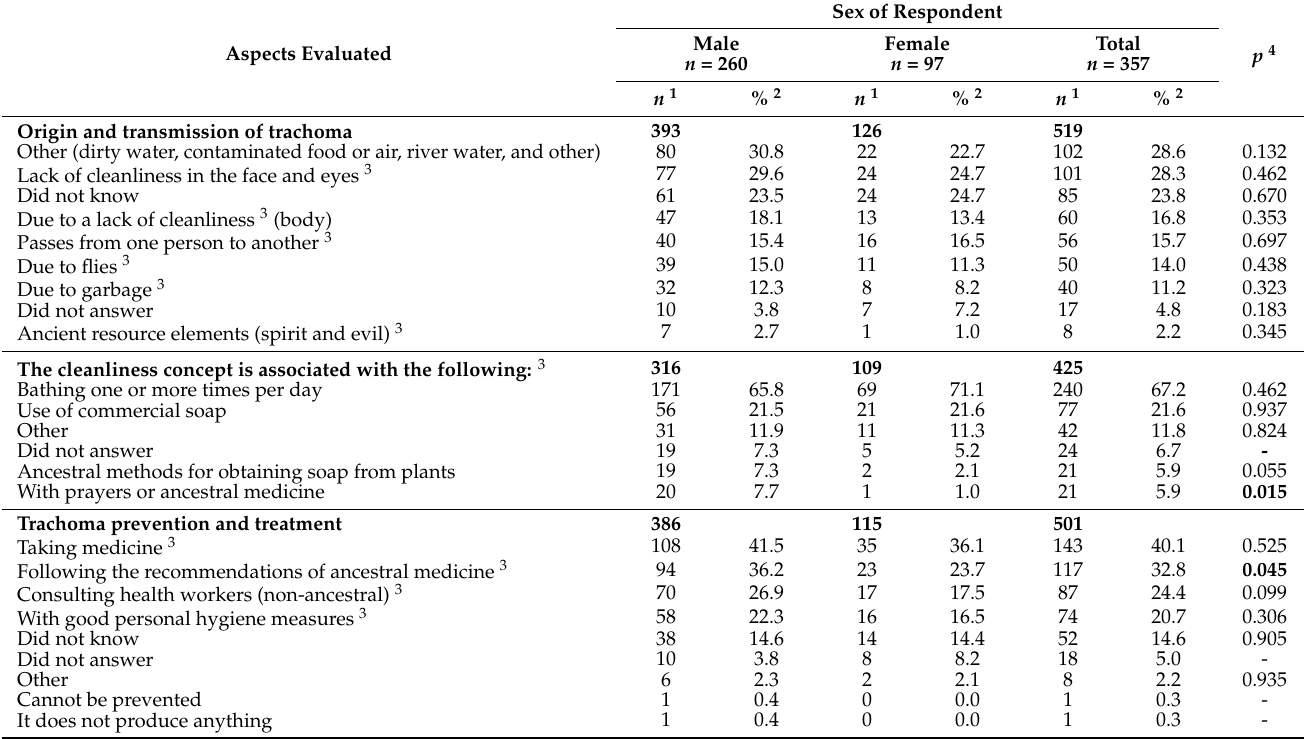
Table 2. Knowledge about the origin, transmission, prevention, and treatment of trachoma, along with cleanliness, according to sex, in the knowledge, attitudes, and practices